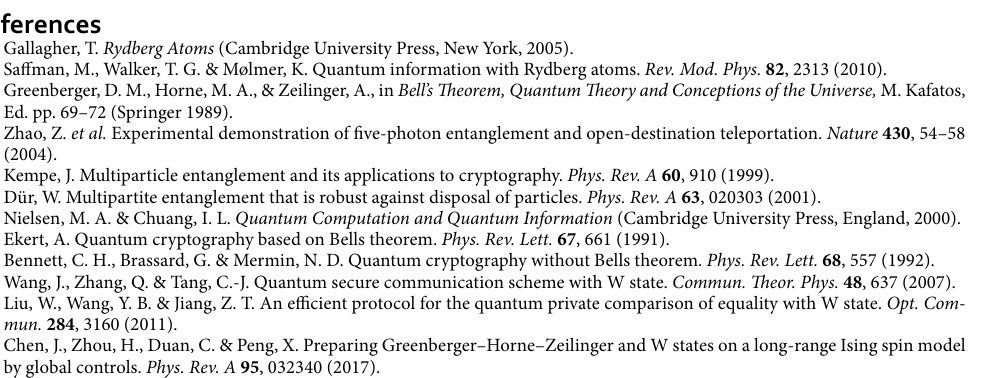
32 MHz/ µ s, and V 21 = −